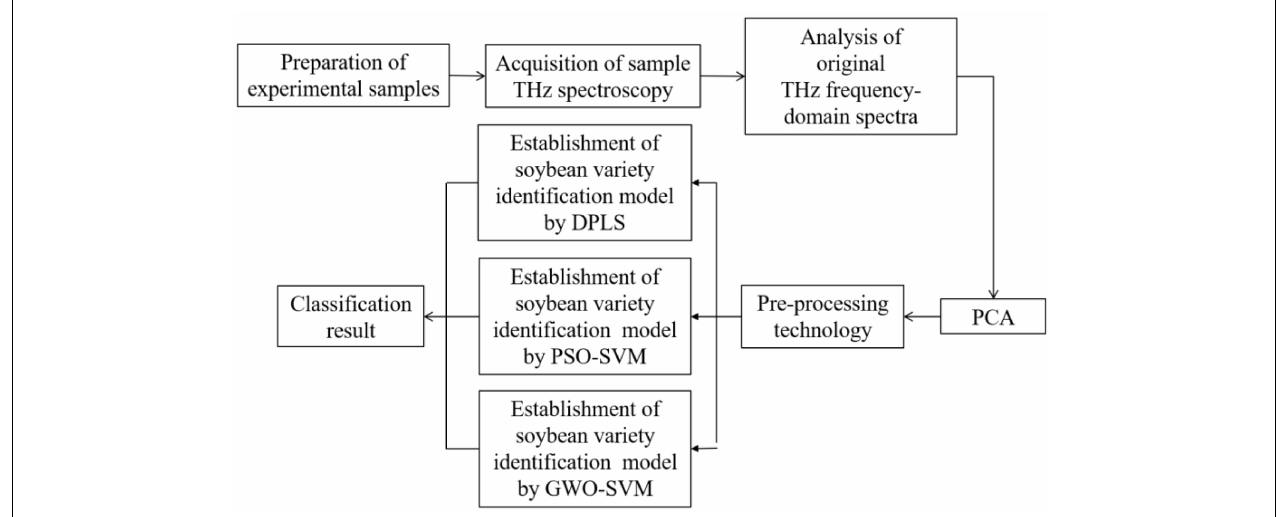
FIGURE 1 | Research